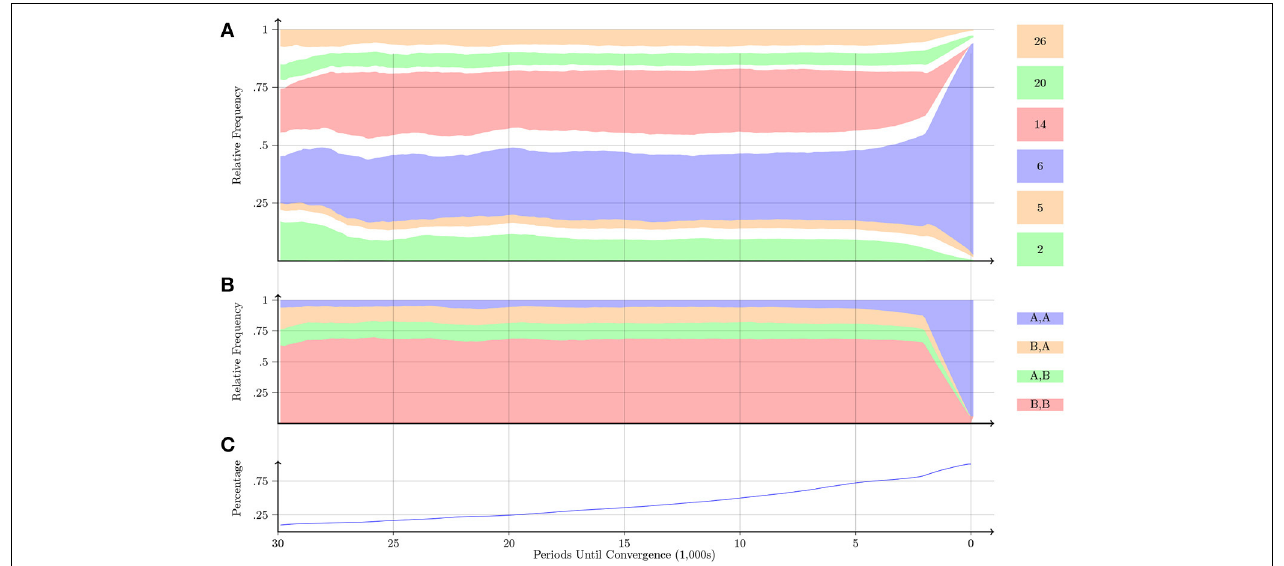
FIGURE 7 | Prisoner’s Dilemma. Notes: Figures 7 – 10 follow the same structure. The plots display information about the progression of play relative to the periods until convergence. The far right of all plots (labeled as “0” on the x-axis) is the point of convergence. (A) Shows the progression of the relative frequency of play across the 26 automata over the last 30,000 periods. The automata are ordered starting from Automaton 1 and moving up to Automaton 26. The height of a region at a certain x-value denotes the relative frequency with which an automaton was played at a given number of periods before convergence. We display in color only those automata with a